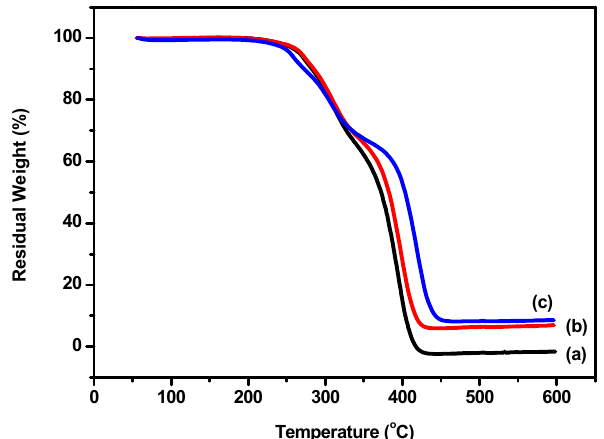
Figure 5. Thermogravimetric (TG) curves of waterborne polyurethane: ( a ) WPU; ( b ) WPU-H, and ( c ) SCPU.